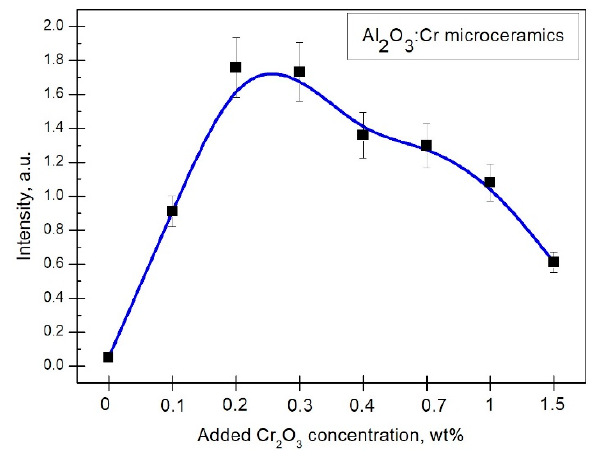
Figure 5. X-ray luminescence intensity dependence on added chromium concentration of Al 2 O 3 : Cr microceramics.